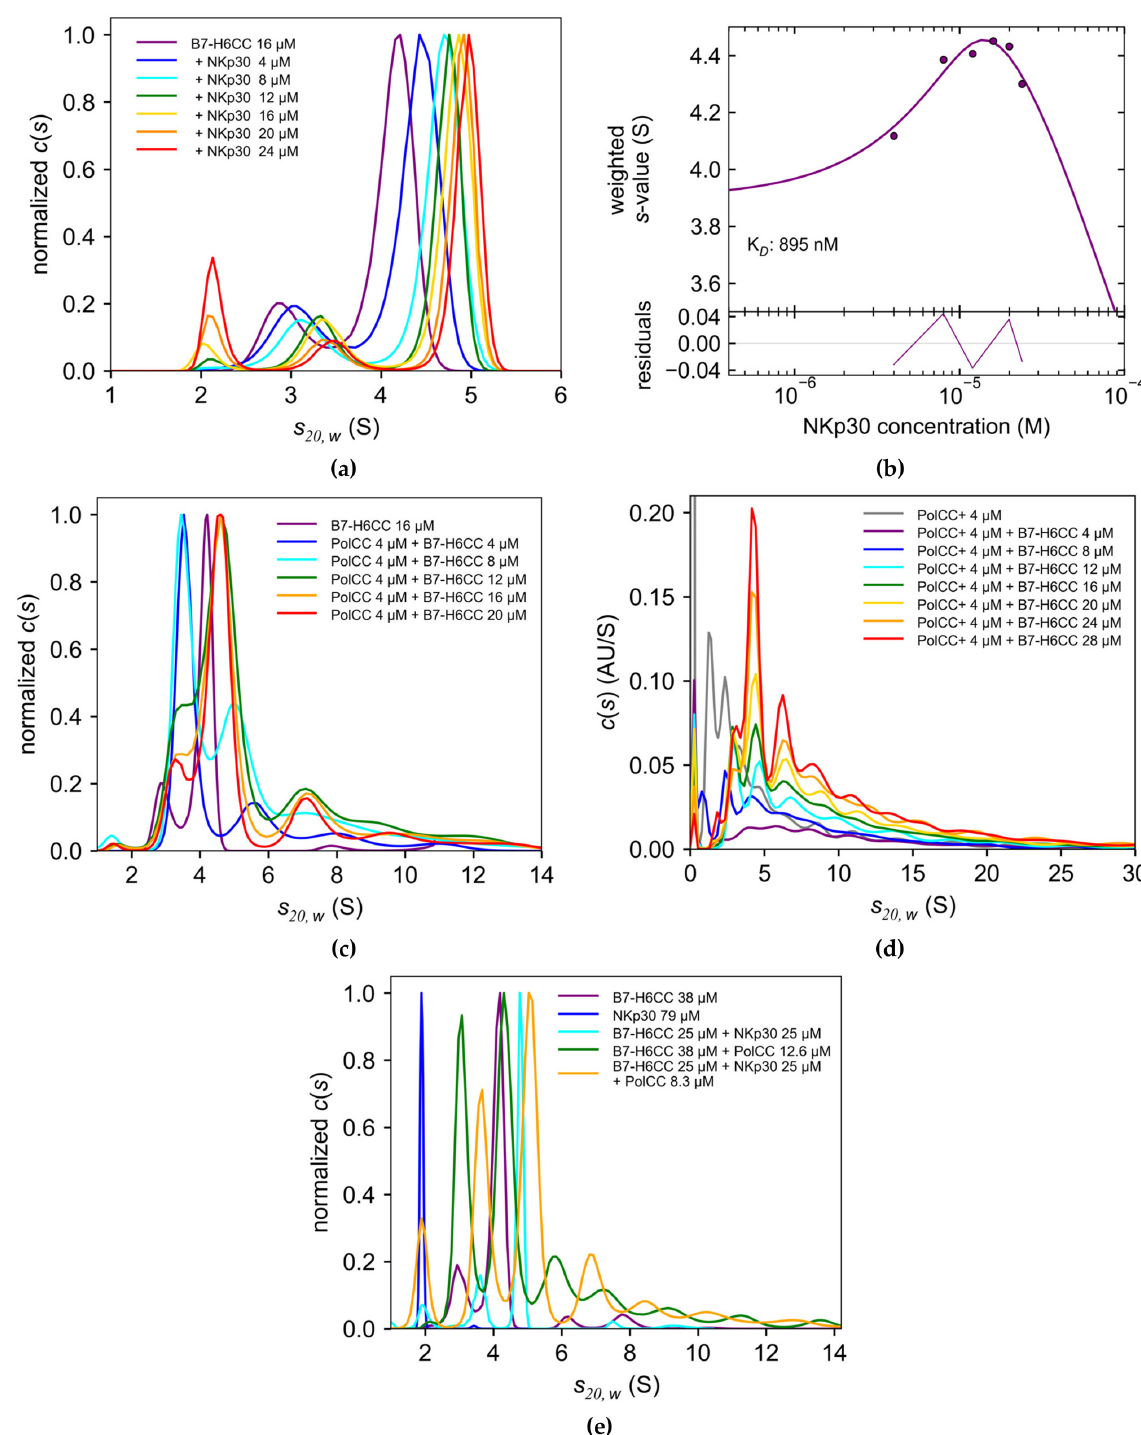
Figure 3. B7-H6CC binds both to the coiled coil peptide-polymer conjugate and to the receptor NKp30. ( a ) Sedimentation velocity analytical ultracentrifugation analysis of B7-H6CC titration with NKp30 shows that both monomeric and dimeric B7-H6CC bind NKp30; ( b ) Binding isotherm from ( a ) fitted with A + B <=> AB binding model; ( c ) PolCC titration with B7- H6CC shows successful hetero-association of the coiled coil peptide pair leading to polyvalent polymer–protein complexes; ( d ) PolCC+ titration with B7-H6CC shows a significantly larger proportion of PolCC+:B7-H6CC polymer–protein complexes with higher stoichiometries than observed for PolCC in ( c ). ( e ) NKp30 receptor binds both to the free and polymer-bound forms of